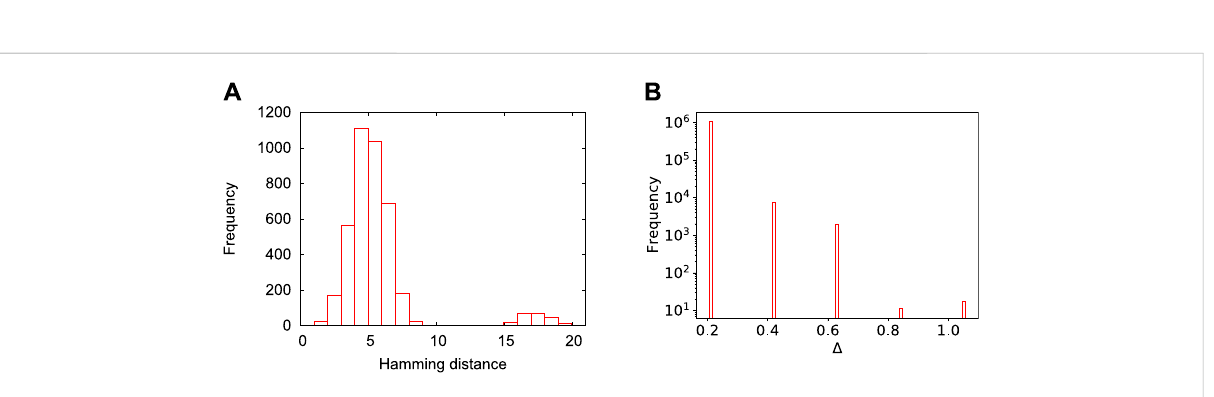
FIGURE 3 (coloronline)SameasFigure1exceptthattheprobleminstancebelongstotheclassof N =20REGproblems.Thereareonly fi vedistinctenergy differences in this case. The energies of the 4,000 lowest energy levels differ by approximately 24 units.